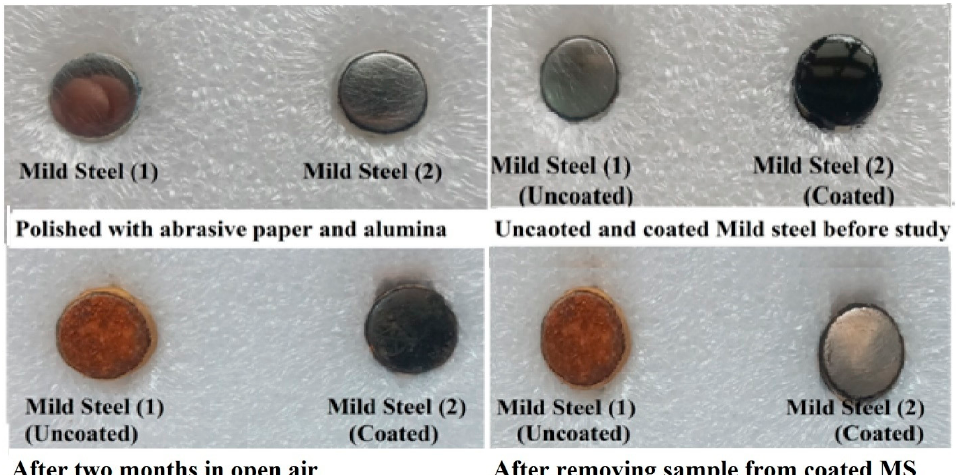
Figure 14. Pictures of uncoated and coated MS before and after the study in open air.